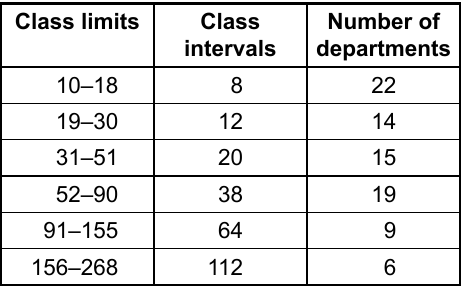
Tab. 2. Class selection according to geometric